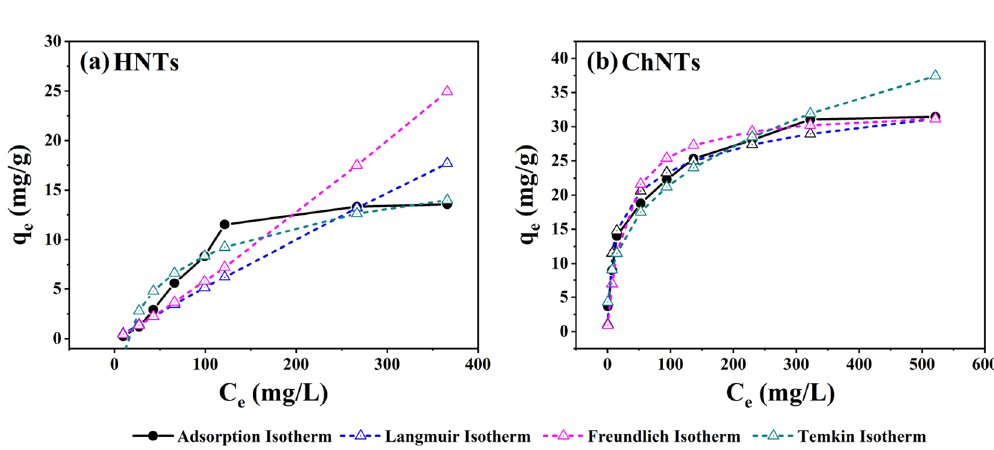
Figure 9. The adsorption model equation fitting isotherm of HNTs ( a ) and ChNTs ( b ) adsorption of MO